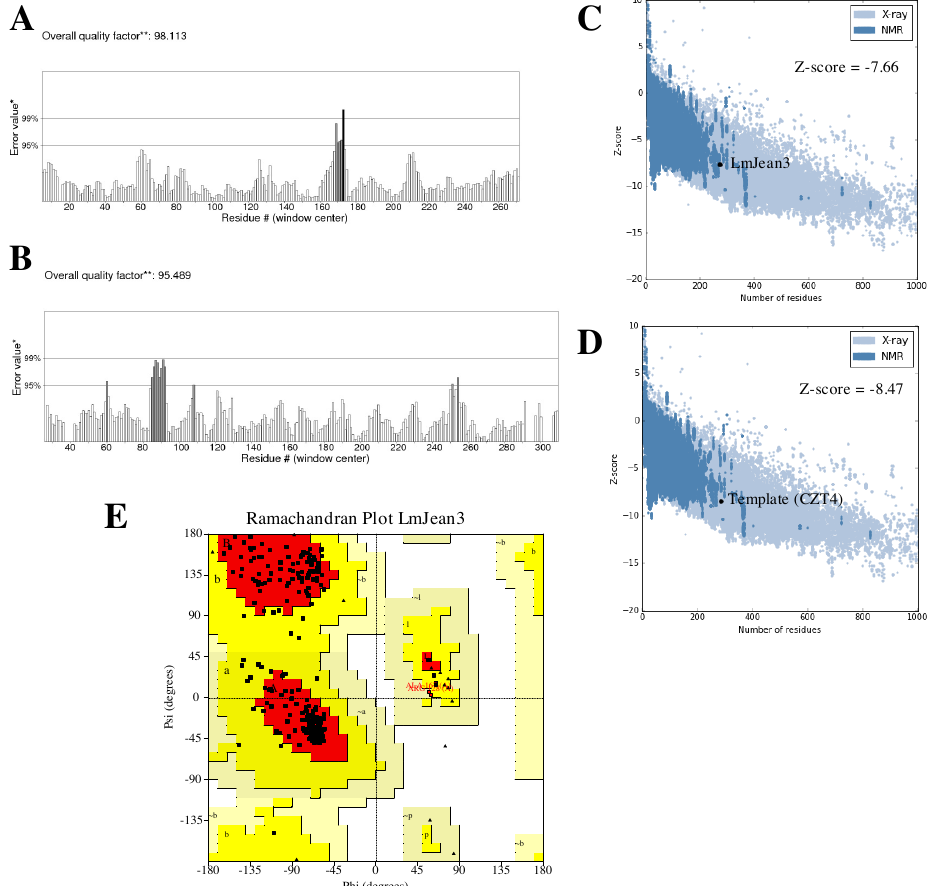
Figure 4. LmJean3 protein structure analysis and evaluation. Statistics of non-bonded